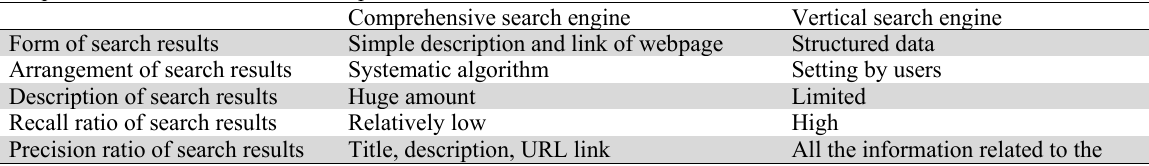
Comparison of Features between Comprehensive and Vertical